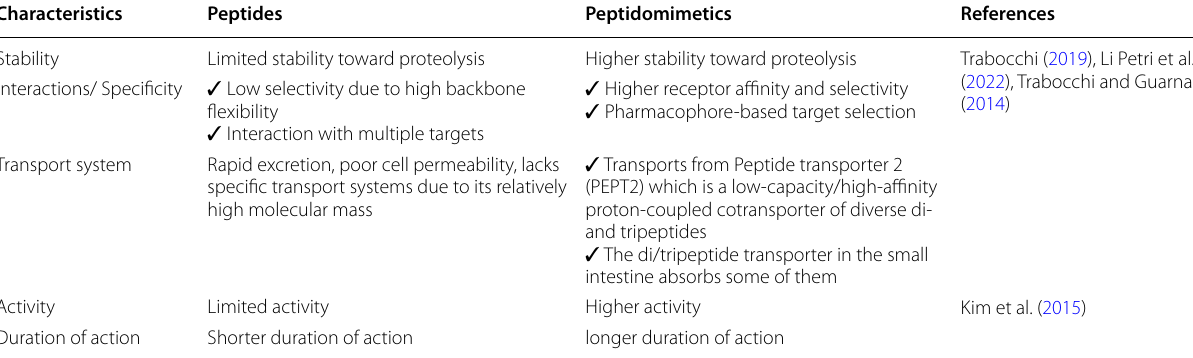
Table 1 Comparing peptidomimetics attributes with native peptides Characteristics